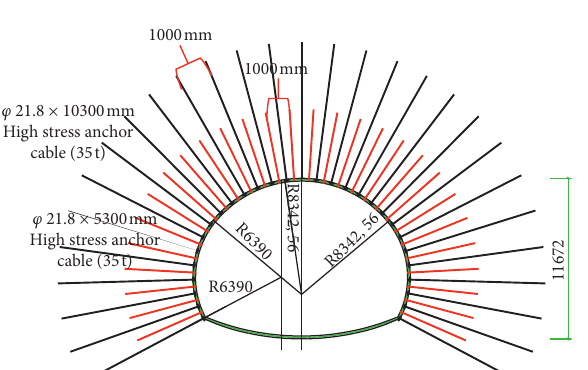
Figure 12: Inclined shaft and main tunnel support scheme